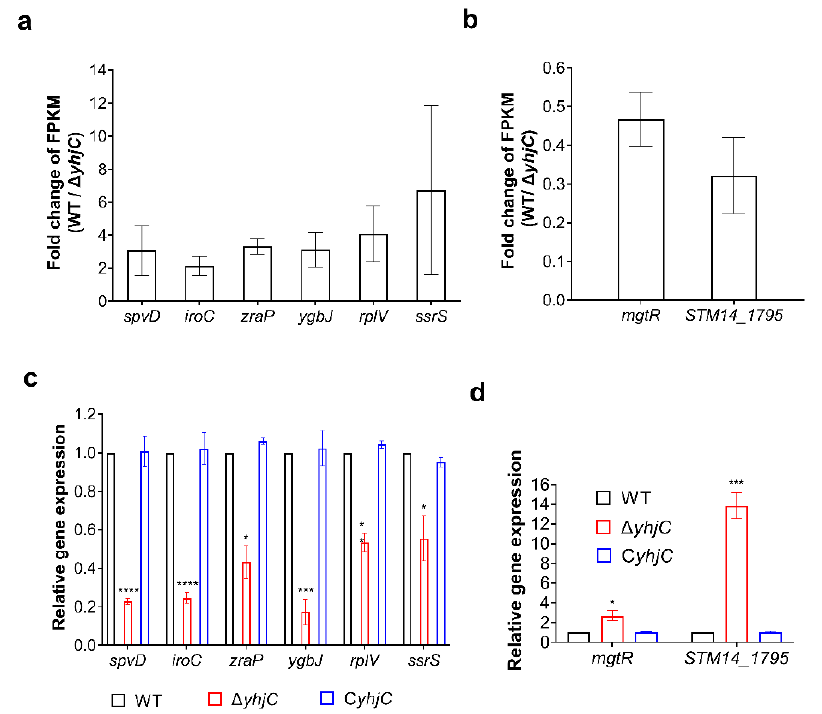
Figure 5. Validation of transcriptome sequencing data. ( a , b ) Fold change in the FPKM of representative differentially expressed genes (DEGs) (WT/ ∆ yhjC ), taken from RNA sequencing data. ( c , d ) RT-qPCR was used to verify the gene expression differences among WT, ∆ yhjC and C yhjC . Unpaired Student’s t -test was used to calculate p values (* p < 0.05; *** p < 0.001; **** p < 0.0001).